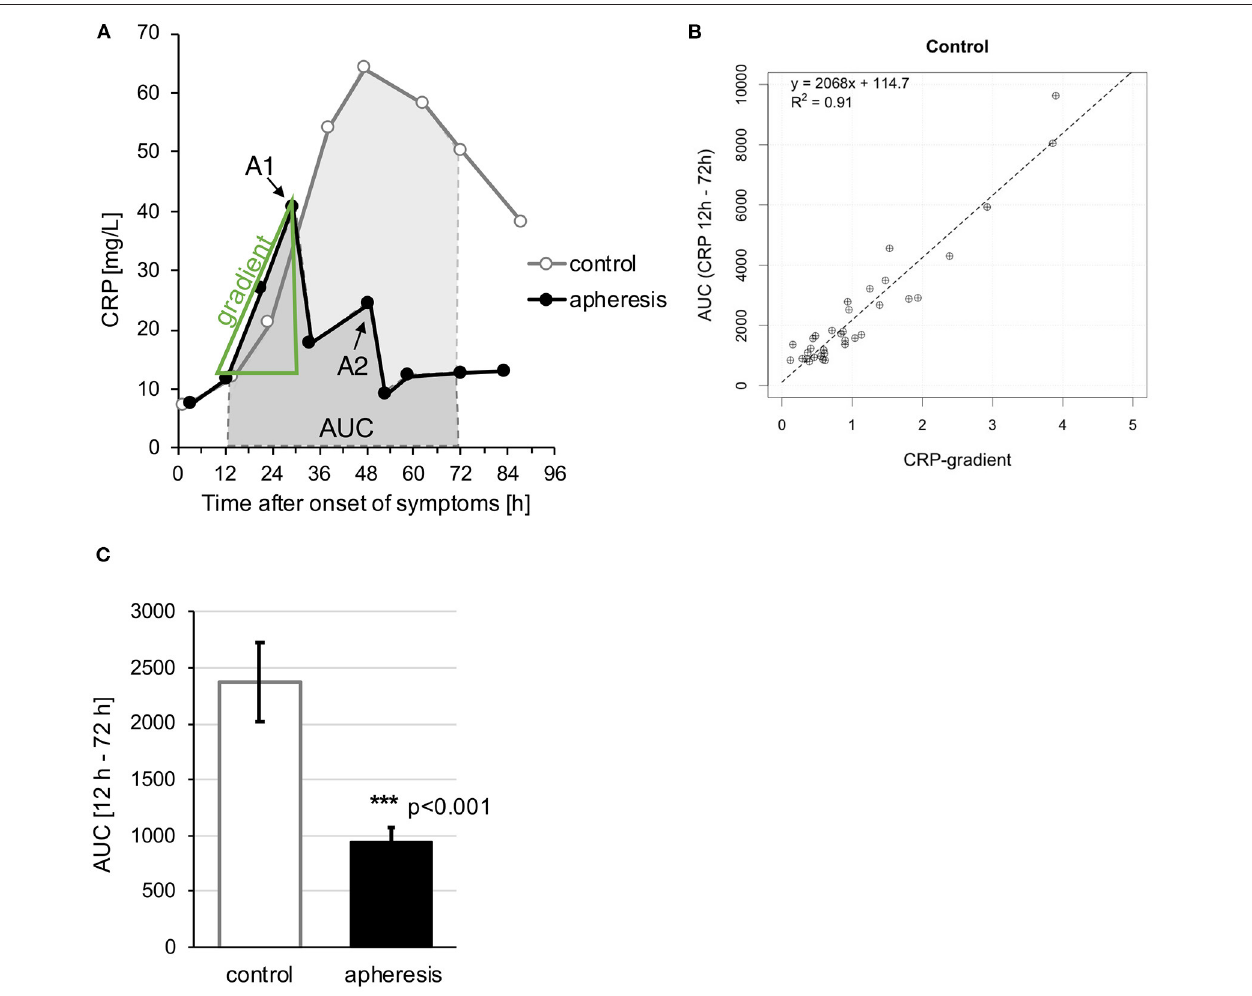
FIGURE 2 | “CRP gradient” and “Area Under the Curve (AUC).” (A) Exemplary schematic analysis of CRP kinetics. Typical kinetics with (“apheresis”) and without (“control”) CRP apheresis. From the initial increase of the CRP curve a gradient was calculated as well as the AUC between 12 and 72h after onset of symptoms. A1 and A2 = apheresis sessions. (B) Comparison of CRP gradient (mg/L/h) with AUC between 12 and 72h. High regression coefficient of > 0.9 for the control group. The relationship of AUC and gradient is shown in more detail in Supplementary Figure 1 . (C) The graph shows the mean AUC of each group ± SEM. Highly significant AUC reduction due to CRP apheresis ( p <